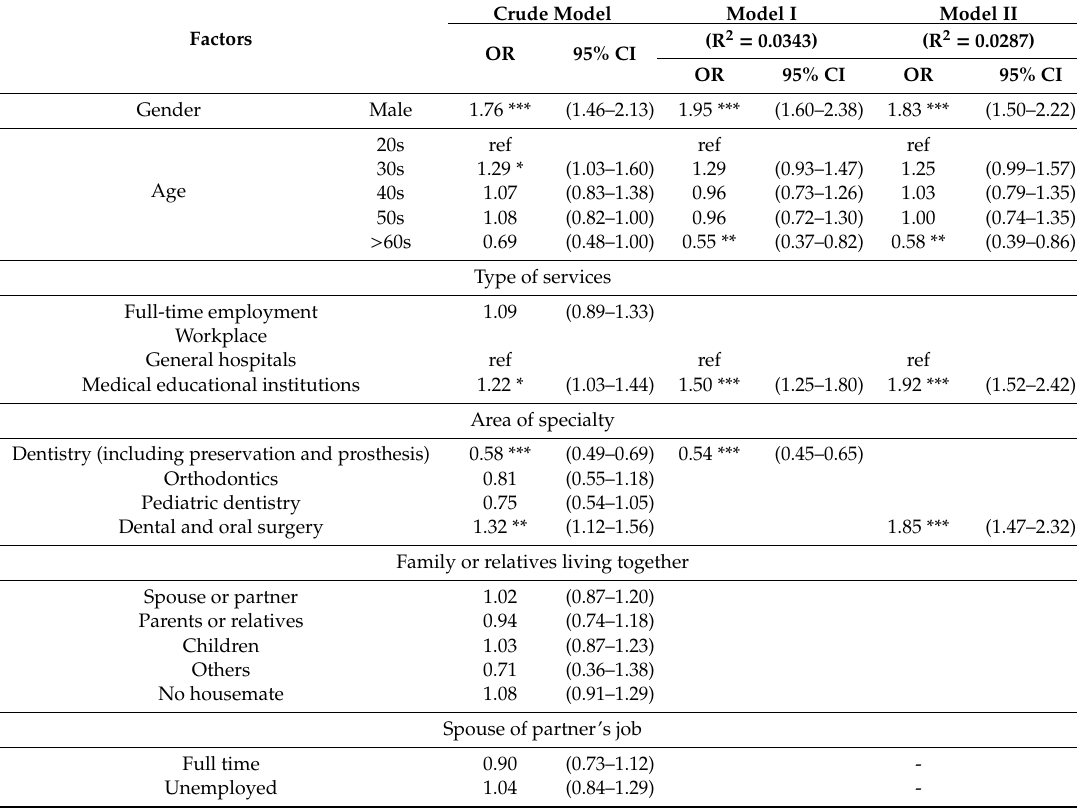
Table 2. Logistic regression analysis for the factors related to the working hours over 60 h per